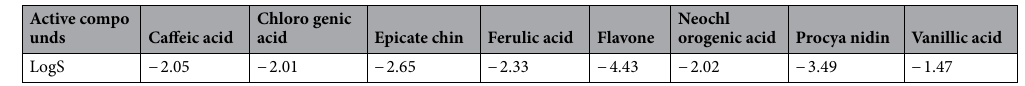
Table 1. LogS values calculated for phytoactive compounds.